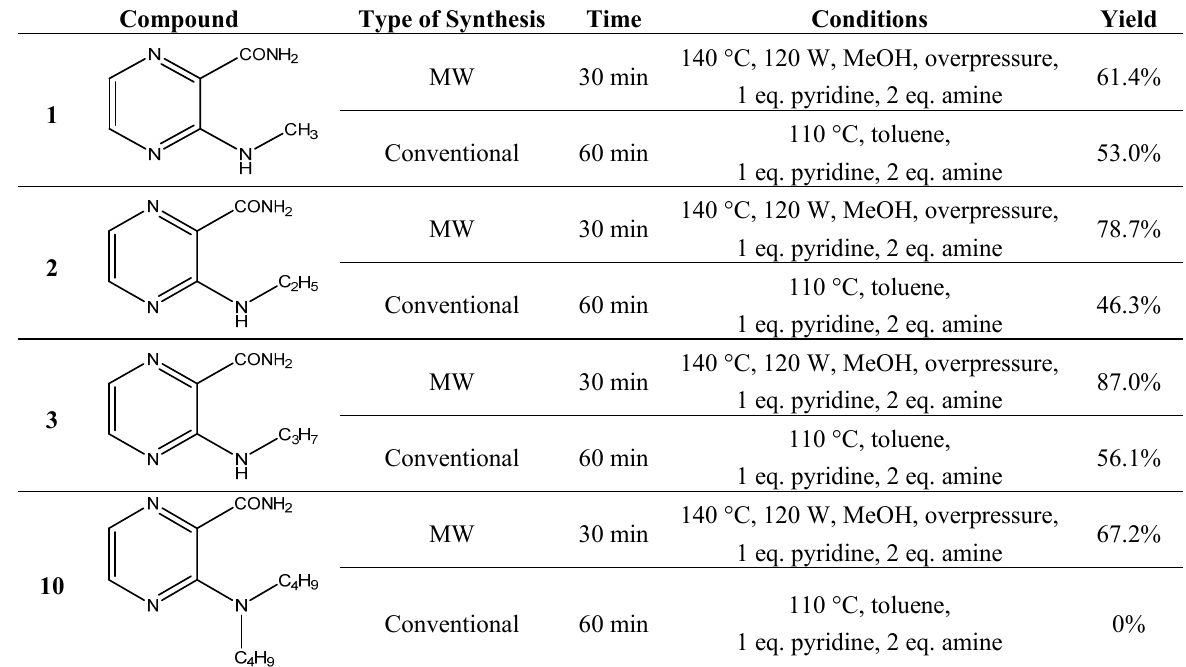
Table 1. Table comparing the efficiency of conventional and microwave-assisted methodology showing the yields, reaction times and conditions.